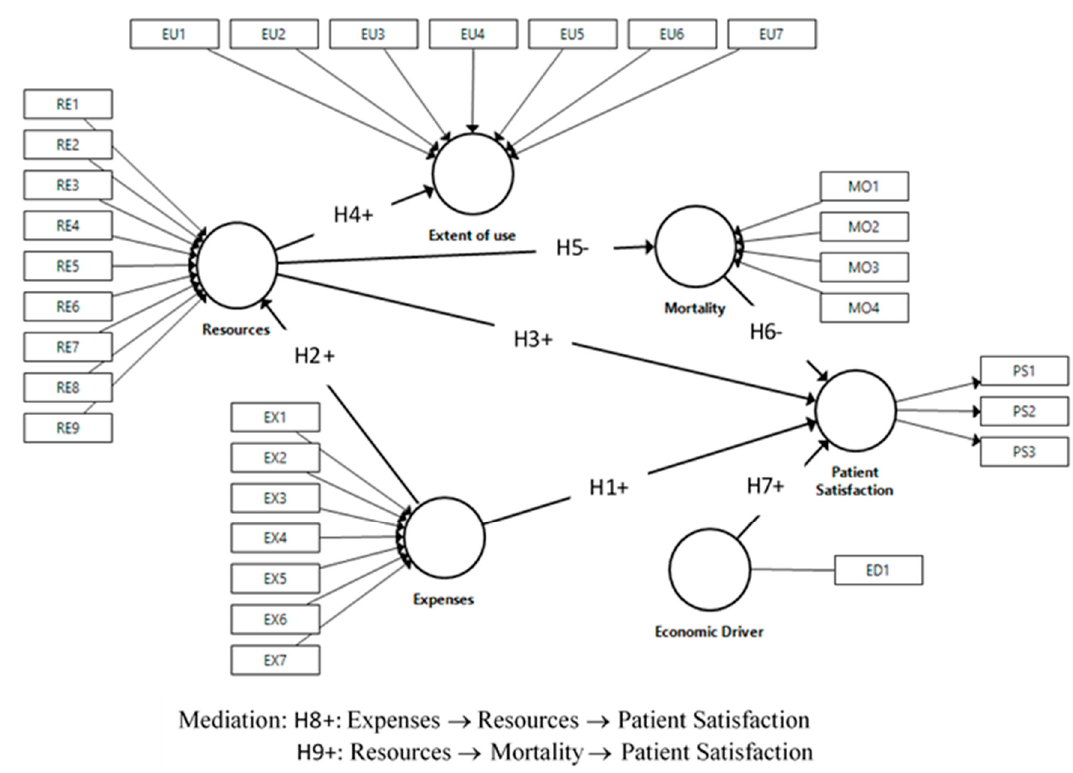
Figure 1. Research model and hypotheses. PS: Patient Satisfaction, EX: Expenses, RE: Resources, EU: Extent of use; MO: Mortality, ED: Economic driver.